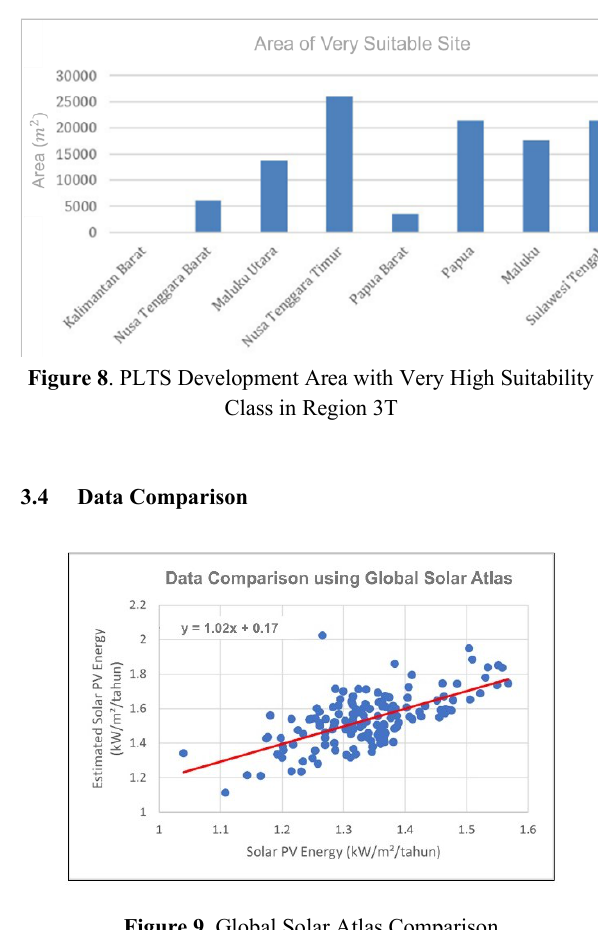
Figure 9 . Global Solar Atlas